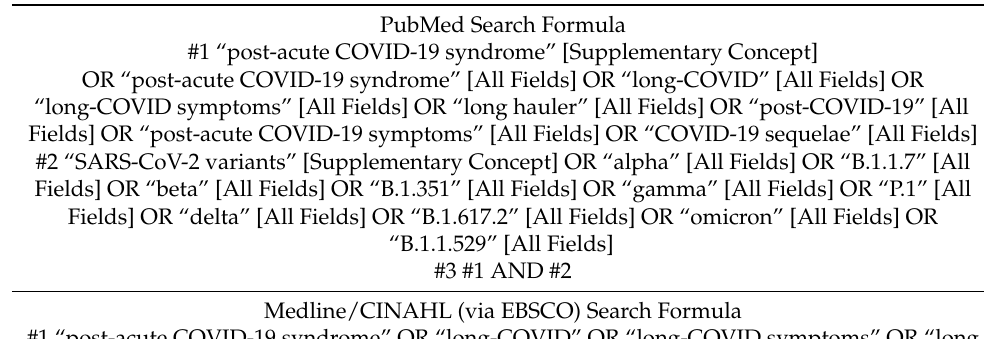
Table 1. Database formulas during the literature search. PubMed Search